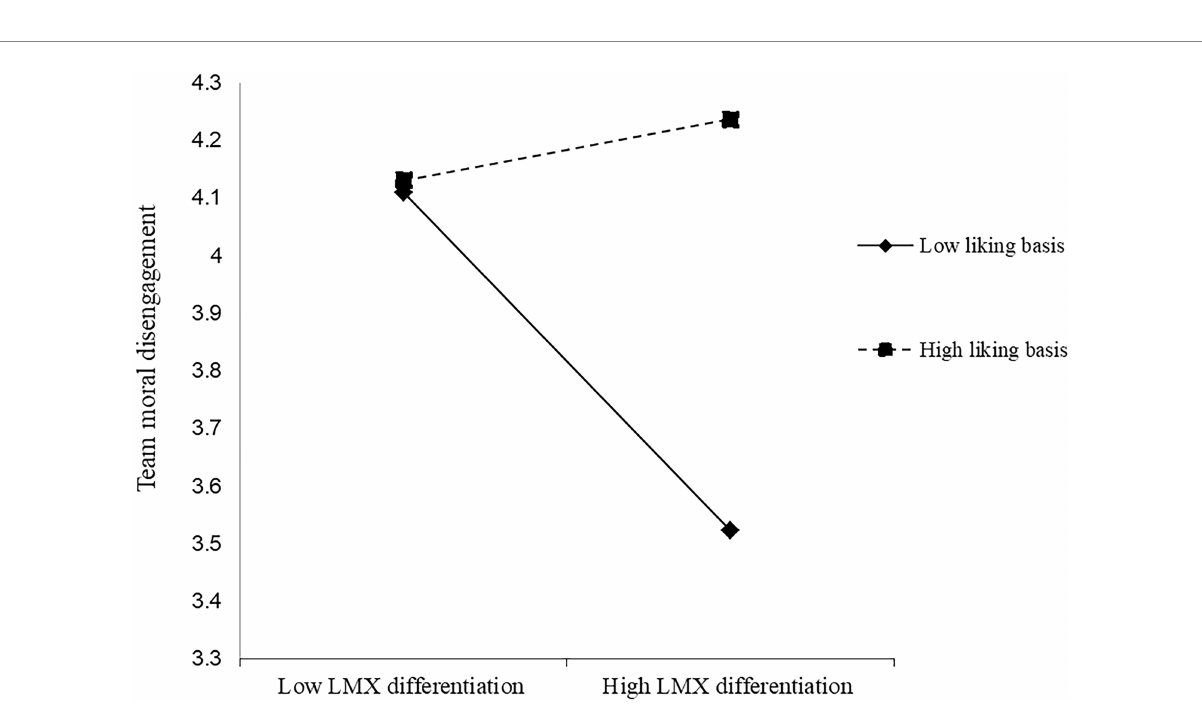
FIGURE 3 Interaction between LMX differentiation and liking